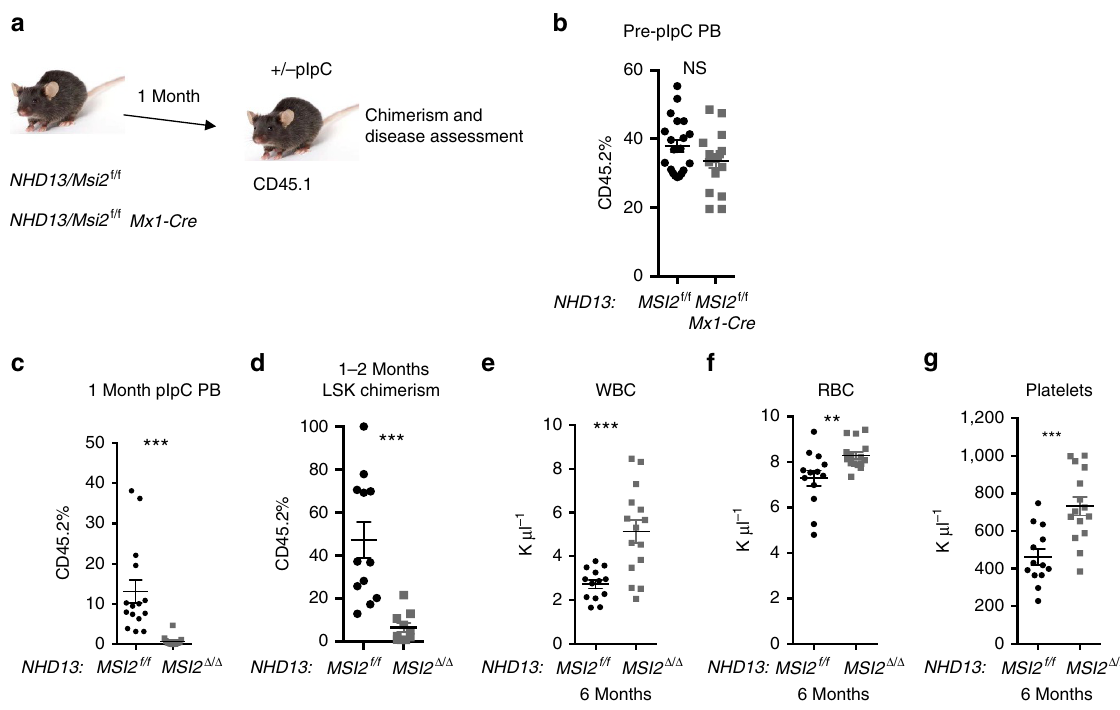
Figure 2 | Msi2 is required to maintain MDS. ( a ) Transplant scheme for Msi2 conditional knockout in NHD13 MDS model. ( b ) Peripheral blood chimerism 4 weeks posttransplantation as described in a , ( NHD13/Msi2 f/f n ¼ 20 and NHD13 / MSI2 f/f Mx1-Cre; n ¼ 18). ( c ) Peripheral blood chimerism 8-weeks posttransplantation (4-weeks post-pIpC treatment; NHD13/Msi f/f n ¼ 15 and NHD13/Msi2 D / D Mx1-Cre; n ¼ 14). ( d ) Chimerism within the haematopoietic stem and progenitor cell compartment from bone marrow aspirates performed 8-weeks posttransplantation, gated on Lin-Sca1 þ Kit þ cells, ( NHD13/Msi2 f/f n ¼ 12 and NHD13/Msi2 D / D Mx1-Cre; n ¼ 10). ( e ) WBC. ( f ) Red blood cells (RBC). ( g ) Platelets at 6 months posttransplant, f – h , (analysed at 6 months post- pIpC, NHD13/Msi2 f/f n ¼ 13 and NHD13/Msi2 D / D Mx1-Cre; n ¼ 15). Data in b – g are represented two independent transplants * P o 0.05, ** P o 0.01, *** P o 0.001, Student’s t -test horizontal line is the mean ±